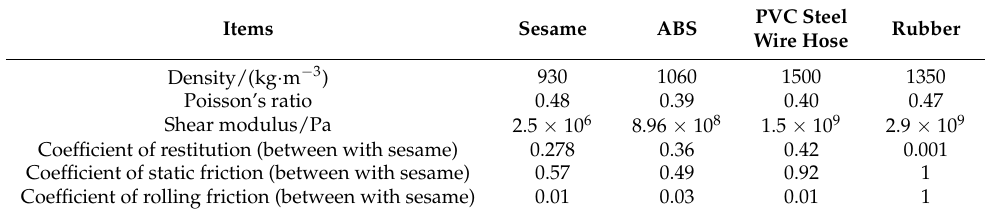
Table 1. Mechanical parameters of materials for